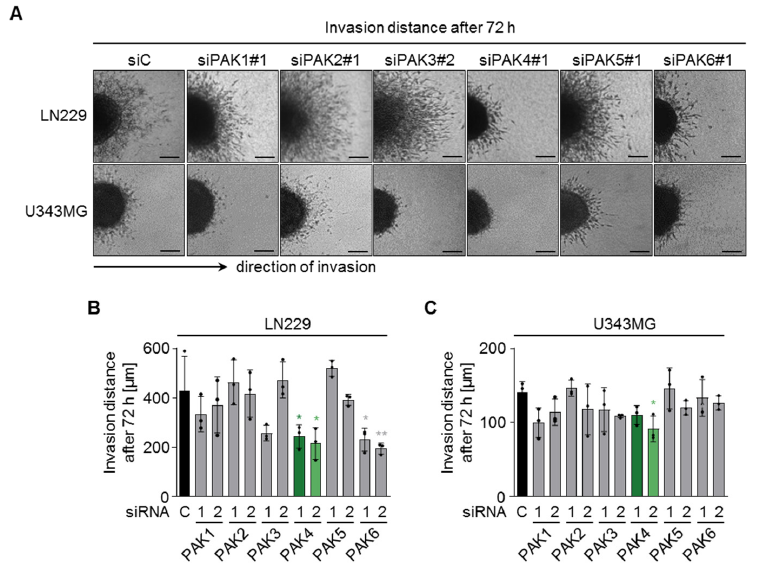
Figure 2. PAK isoforms differentially regulate glioblastoma cell invasion. ( A ) Representative images of LN229 and U343MG spheroids 72 h after transfer to a three-dimensional collagen type I matrix. Scale bar: 200 µm. ( B ) Quantification of invasion distance of LN229 cells and ( C ) U343MG cells upon knockdown of the different PAK isoforms and 72 h of invasion. ( B , C ) Data show means +/ − SDs (N = 3 independent experiments, ∑ n = 15 spheroids per treatment condition, one-way ANOVA, Dunnett’s post-hoc test, * p < 0.05, ** p < 0.01).